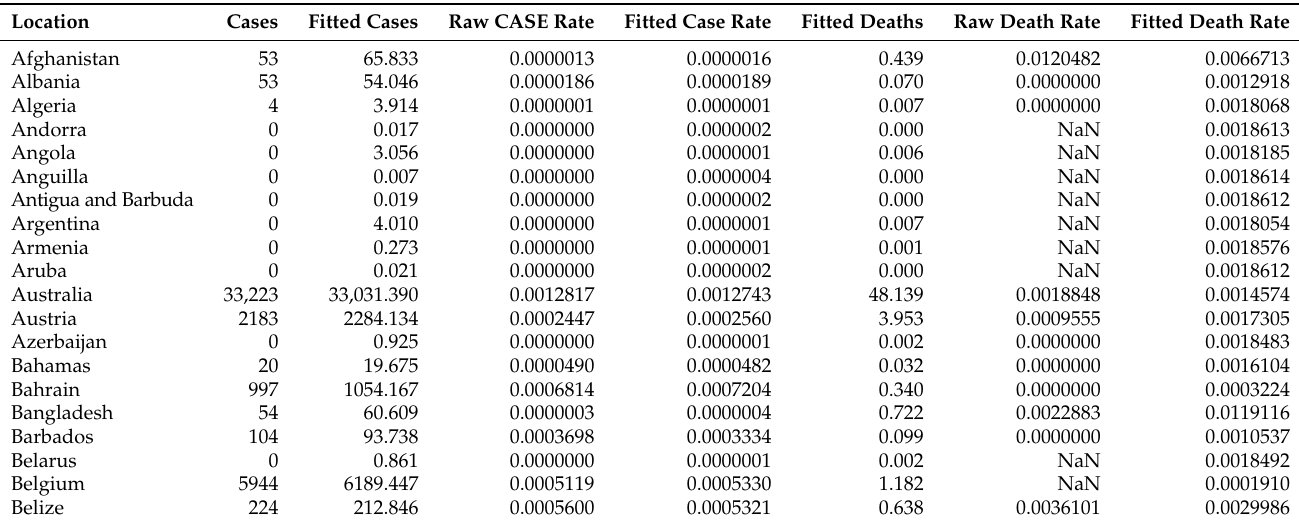
Table 3. Raw and fitted case and death rates, on Tuesday, 21 June 2022, relative to cases 14 days earlier (i.e., Tuesday 7th of June). Population and death counts omitted since they are the same as in Table